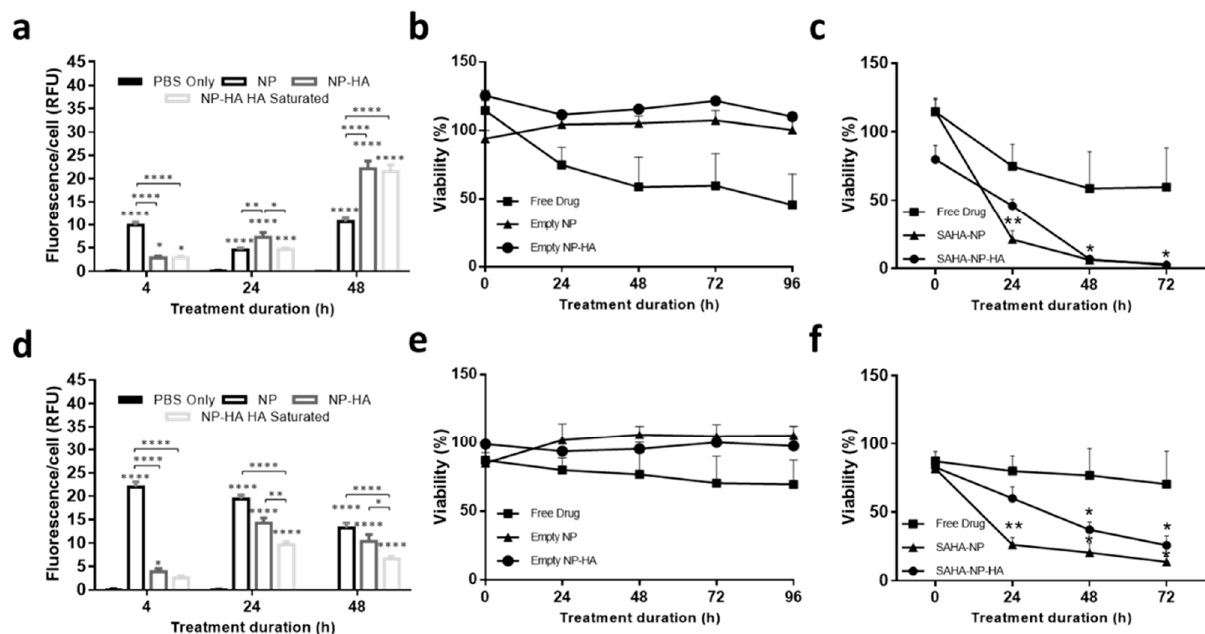
Figure 4. Nanoparticle uptake in 2D endometrial cancer models. Quantified uptake in Ishikawa ( a ) and Hec50 ( d ) per cell from 3 repeats, 9 fields per repeat, treatments were NP (black), NP-HA (dark grey) and NP-HA following HA saturation (light grey) compared to negative control PBS only (black with black fill). All treatments were 2.5 µ M. Statistical analyses shown are results from one-way ANOVAs compared against PBS only unless indicated otherwise. Nanoparticle systems cytotoxicity in in vitro endometrial cancer models. RT-Glo viability curves for free drug (squares), Empty NP (triangle) and Empty NP-HA (circle) at 2.5 µ M concentration for Ishikawa ( b ) and Hec50 ( e ) over a 96 h period ( n = 4). All data was normalized to the untreated control cells. Encapsulated SAHA-NP drug systems cytotoxicity in vitro endometrial cancer models. Monolayer cellular viability using Real Time Glo viability test ( n = 3) of SAHA Free Drug (square), SAHA-NP (triangle) an SAHA-NP-HA (circle) at the concentration of 2.5 μ M for Ishikawa cell line ( c ) and Hec50 ( f ). All data was normalized to the untreated control cells. Statistical significance is indicated on graphs: p ≤ 0.05 denoted by *, p ≤ 0.01 by ** and p ≤ 0.0001 by ****.